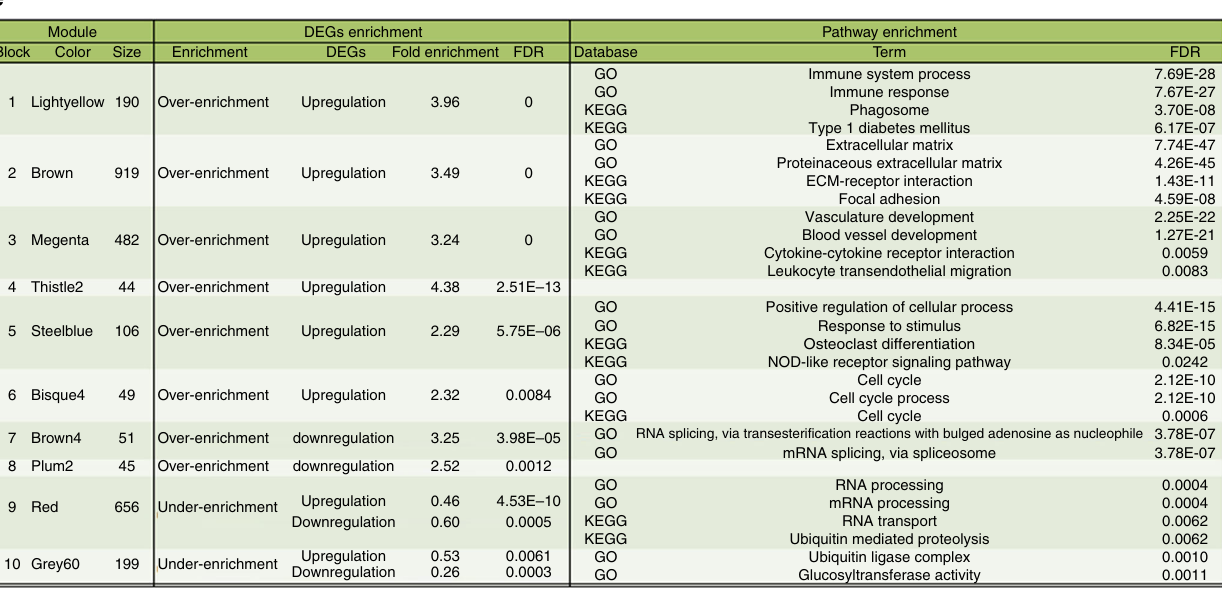
Fig. 2 Global molecular characterization of transcriptomes from the 25 insulinomas compared with beta cells from 22 normal subjects. a Unsupervised classi fi cation analysis including hierarchical clustering ( above ) and principal component analysis ( below ) of insulinomas vs. ZsGreen-sorted beta cells (ZS beta) 25 , Newport green-sorted beta cells (NG beta) 24 and beta cells from insulin-antibody sorting (IS beta) 23 . Note that insulinomas generally differ from normal beta cells regardless of method of beta cell sorting. b Differentially expressed protein-coding genes in insulinomas as compared to beta cells. GCG and PPY refer to glucagon and pancreatic polypeptide Y mRNAs, respectively, and re fl ect the contamination of FACS-sorted beta cells with alpha- and PP- cells. Ins refers to insulin mRNA, is expressed equally in beta cells and insulinomas. c The top 20 genes containing the most signi fi cant differentially spliced exons, with each column referring to a single sample and color matching the sample color schema in a . Expression levels are shown in the color key, with orange indicating an increase in insulinomas vs. beta cells. Regardless of beta cell sorting method used, abnormal exon splicing in insulinomas is common. d The ten key modules in the insulinoma WGCNA via projection of DEGs. The complete network is shown in Supplementary Fig. 2. e Annotation of the ten key co-expression modules, including statistics for DEG enrichment and for the top enriched GO and KEGG terms (at FDR <